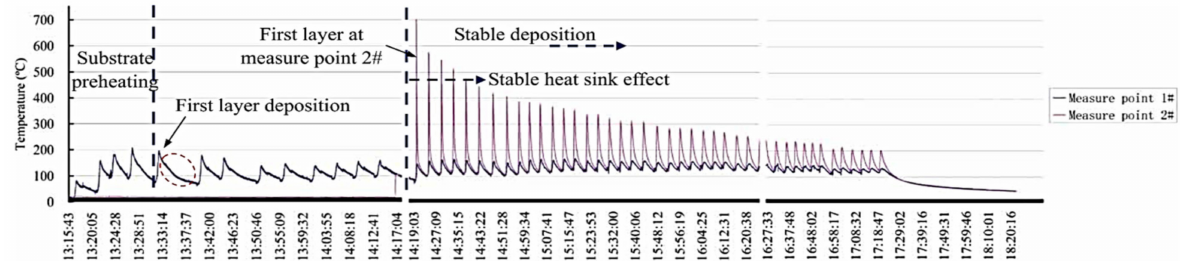
Figure 29. Effect of varying substrate preheating temperature. Reprinted with permission from Ref. [73]. Copyright 2017 Taylor &Francis Ltd.